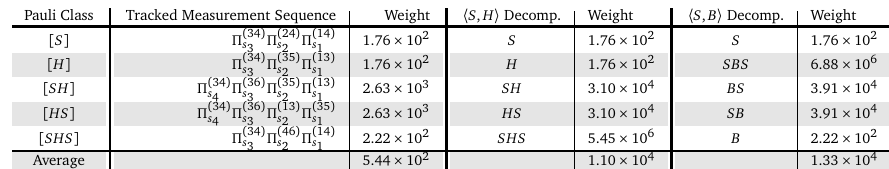
Table 6: Minimal difficulty weight measurement sequences for each Pauli coset of single-qubit Clifford gates when using Majorana-Pauli tracking methods. For comparison, we also present the corresponding realization of the gates formed by using the generating gate sets 〈 S , H 〉 and 〈 S , B 〉